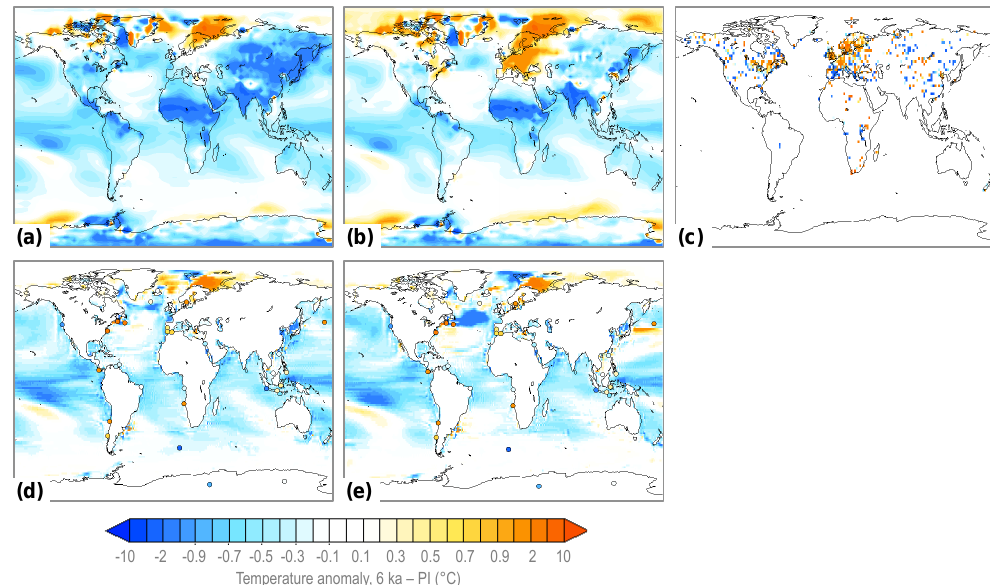
Figure 14. Mid-Holocene minus pre-industrial temperature anomalies: (a) annual mean surface air temperature anomalies from the control experiment; (b) annual mean surface air temperature anomalies from the KK10 experiment; (c) Bartlein et al. (2011) pollen-based recon- structions of the mean annual air temperature anomaly; (d) ocean annual mean temperature for the top two layers (25m) from the control experiment with palaeo-proxy reconstructions (Marcott et al., 2013) overlaid in coloured circles; (e) as in (d) but for the KK10 experiment.